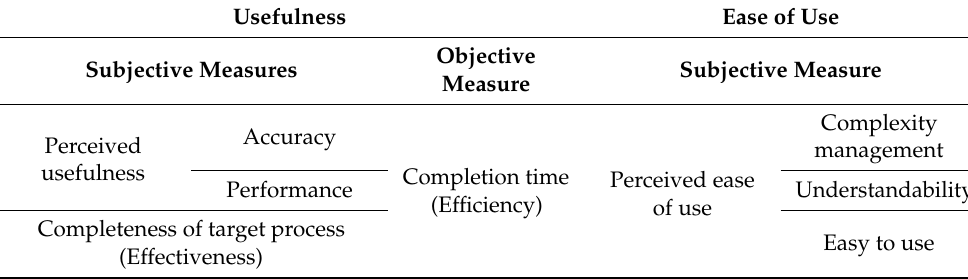
Table 3. Measures used in the